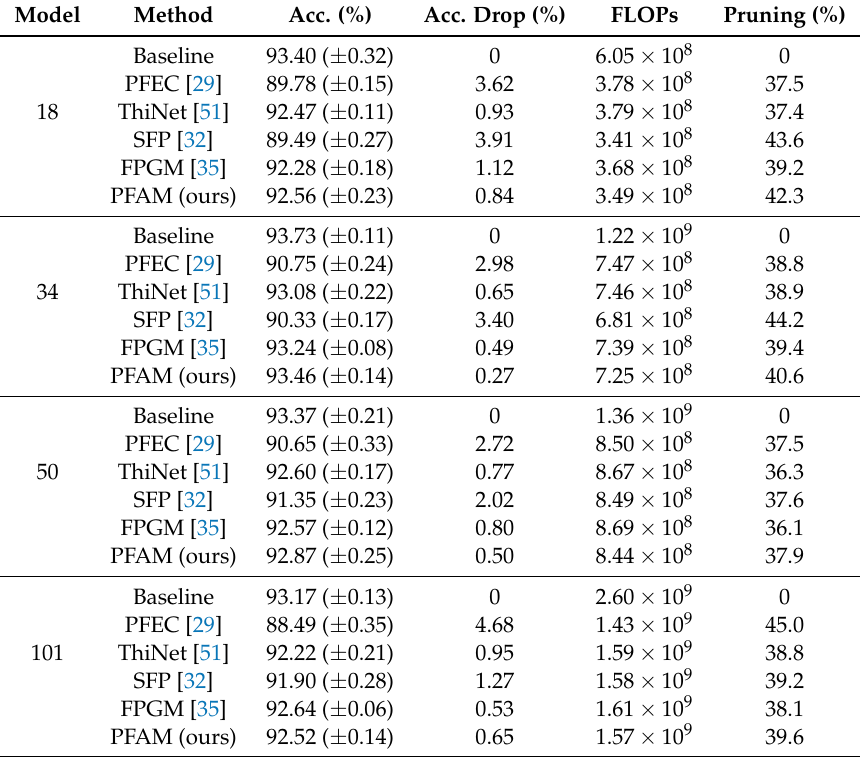
Table 1. Comparison of pruning ResNet on the NWPU-RESISC45 dataset. Acc,